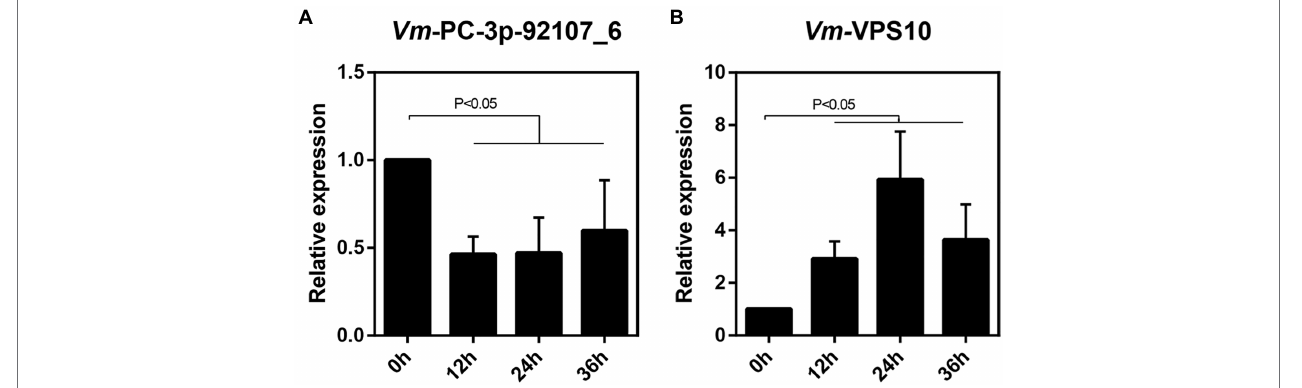
FIGURE 6 | The relative expression pattern of Vm-PC-3p-92107_6 (A) and Vm-VPS10 (B) during V. mali infection.